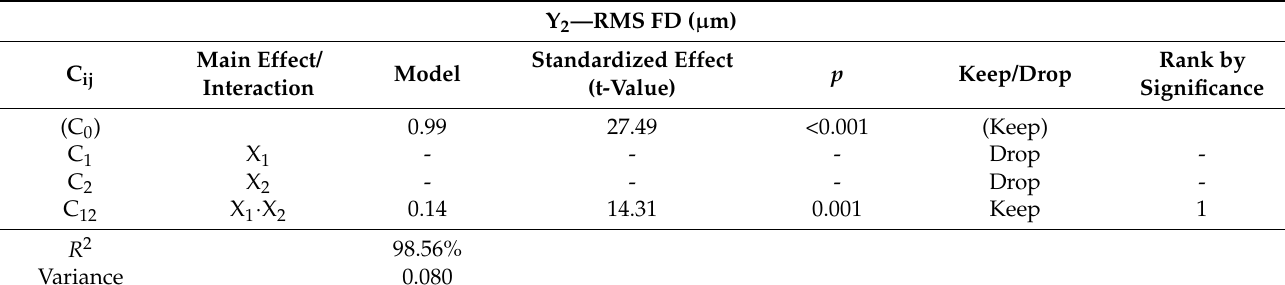
Table 7. Model in coded units for output variable Y 2 obtained by dropping terms with p -value >